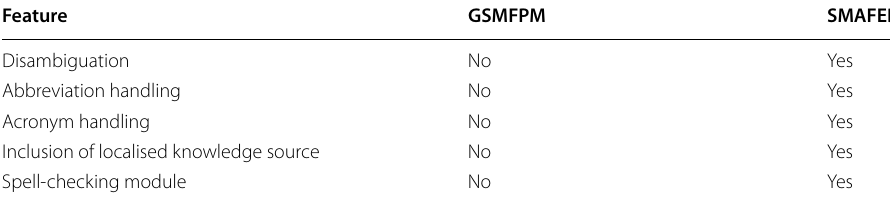
Table 8 Difference between GSMFPM and SMAFED Feature GSMFPM SMAFED Disambiguation